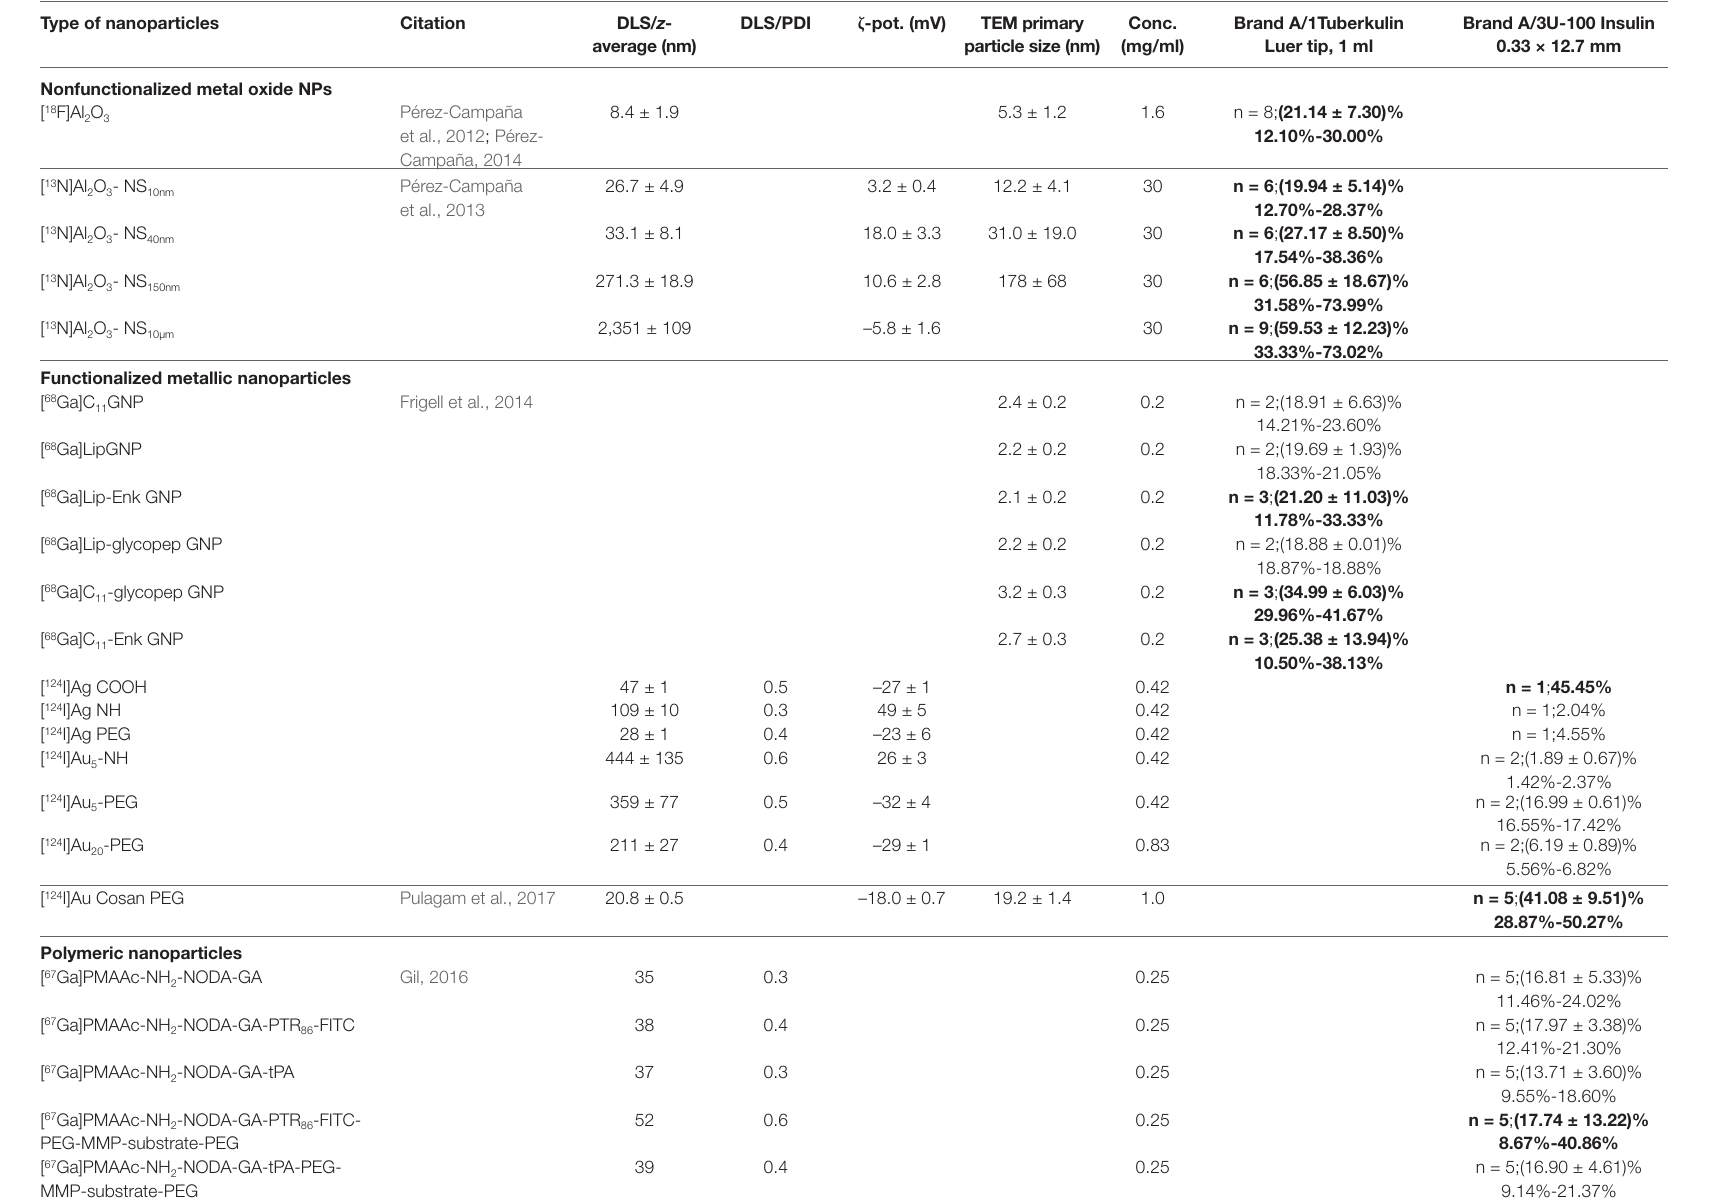
TABLe 3 | Summary of syringe retention and nanoparticle characterization data obtained at CIC biomaGUNE: The number of syringes (n), mean retention and standard deviation and range are given. Type of